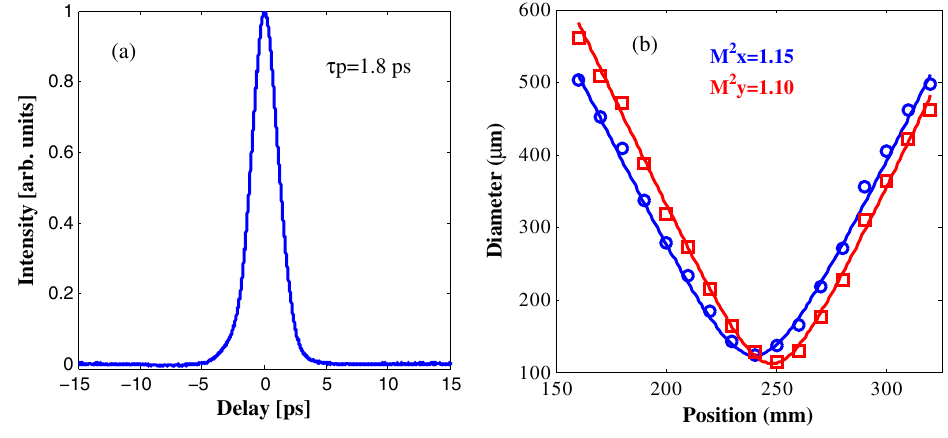
FIG. 5. (a) AC signal; (b) M 2 measurements at 4 W average green